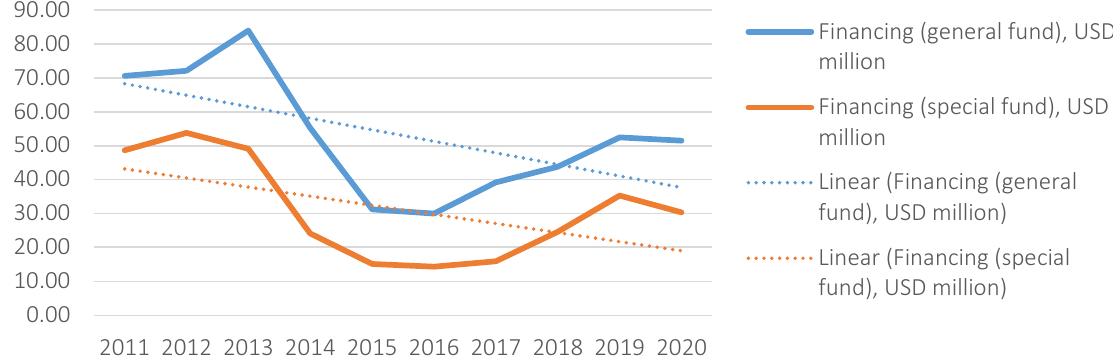
Figure 2. Change in the amount of funding of the University under the general and special